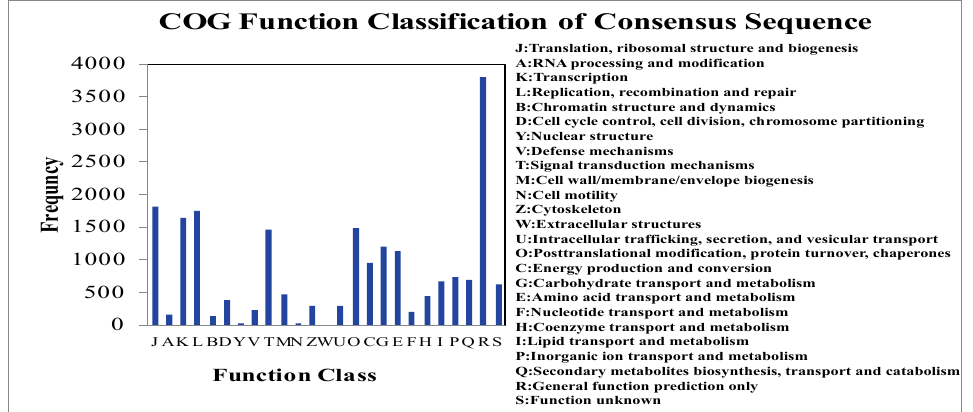
Figure 4. Histogram presentation of clusters of orthologous groups (COG). In total, 20,585 sequences were assigned to 25 COG classifications.